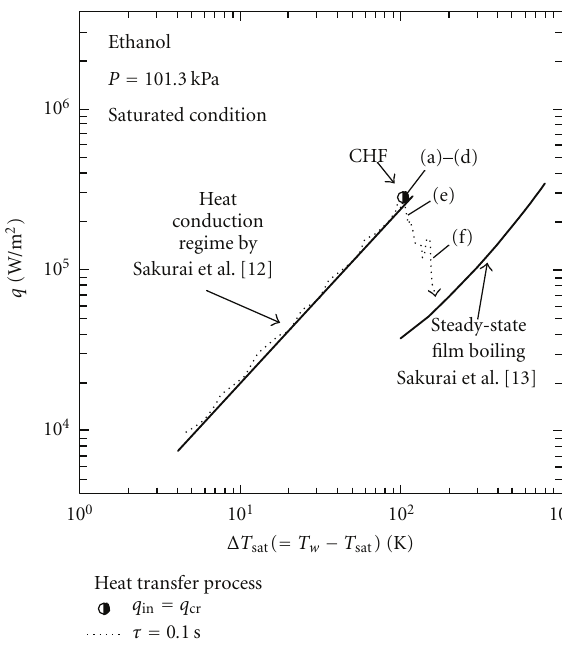
Figure 4: Boiling heat transfer processes from non-boiling to film boiling under saturated condition in ethanol. Photographs